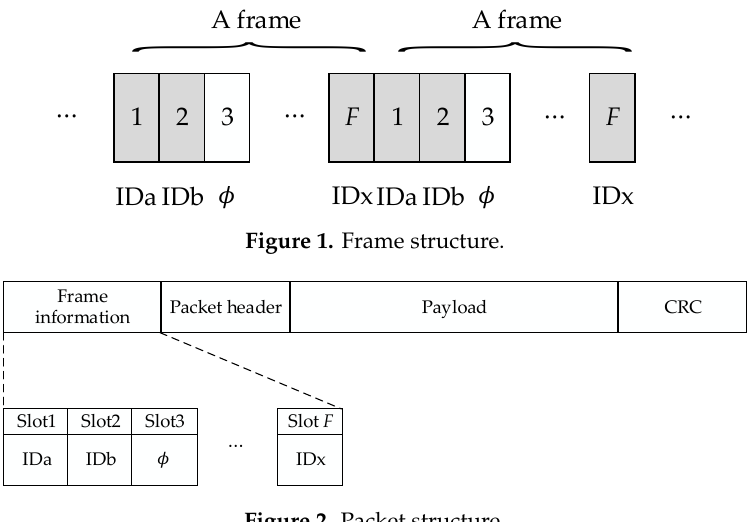
Figure 2. Packet structure. Figure 2. Packet